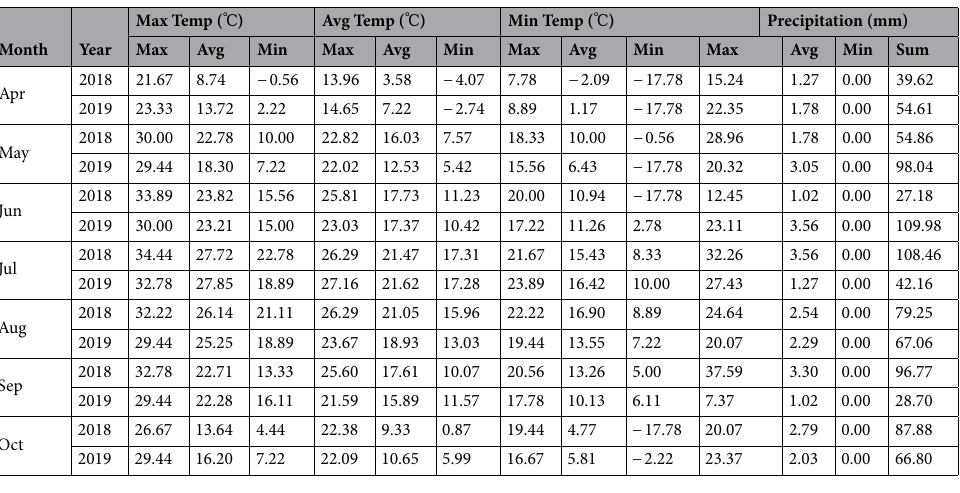
Table 7. Temperature and precipitation data of the experimental site during the growing seasons of 2018 and